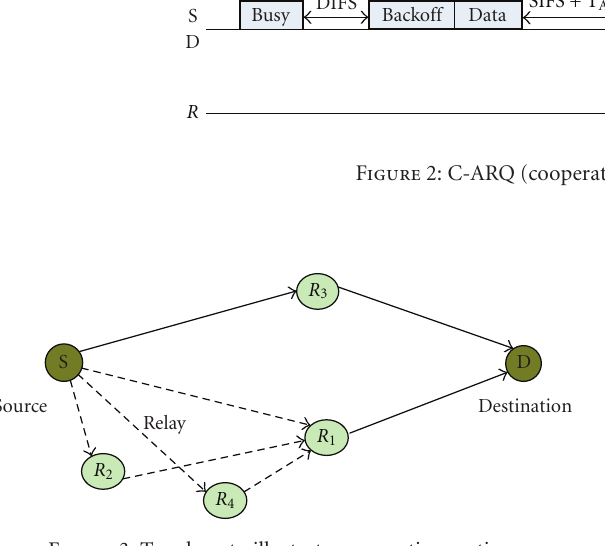
Figure 3: Topology to illustrate cooperative